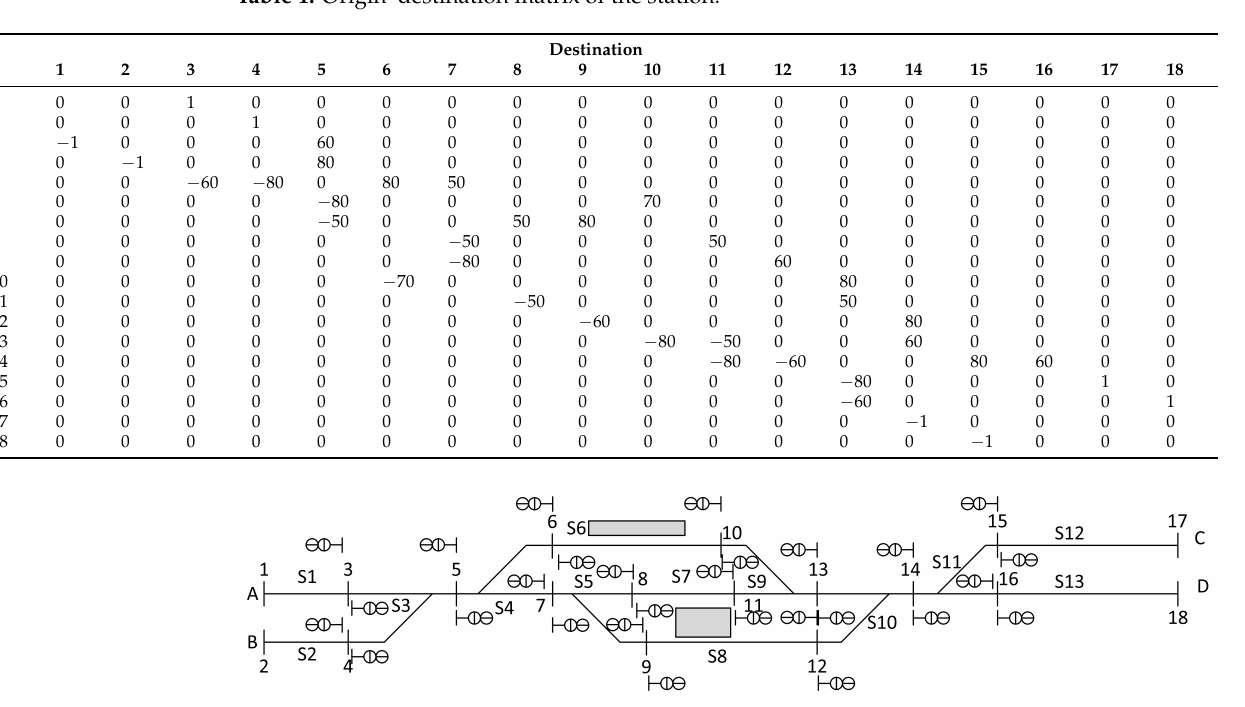
Table 1. Origin–destination matrix of the station.